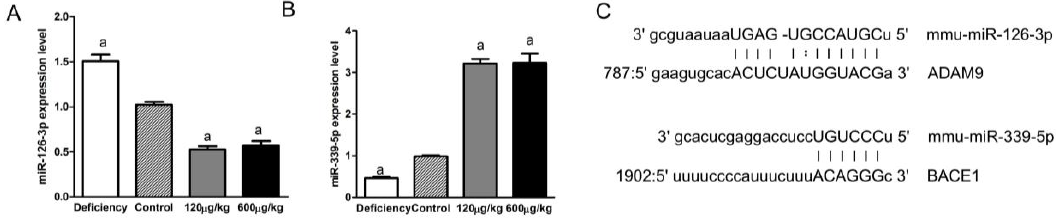
Figure 5. Folate regulated miR-126-3p and miR-339-5p expression in APP/PS1 mice brains. Two miRNA expression levels in the brains of APP/PS1 mice were confirmed by qRT-PCR. ( A ) miR-126-3p was expressed at lower level in both 120 μg/kg and 600 μg/kg groups, it was expressed at higher levels in the deficiency group compared to the control group; ( B ) miR-339-5p was expressed at higher level in both the 120 μg/kg and 600 μg/kg groups, it was expressed at lower level in the deficiency group compared to the control group; and ( C ) predicted miR-126-3p and miR-339-5p target sites in the 3′-UTR of ADAM9 or BACE1. Schematic representation of base pair matching between miRNAs and the 3-UTR of ADAM 9 and BACE1. The seed region of the miRNAs is indicated. The data were expressed as means ± SD values, n = 6 animals/group. a: p < 0.05 versus the control group.